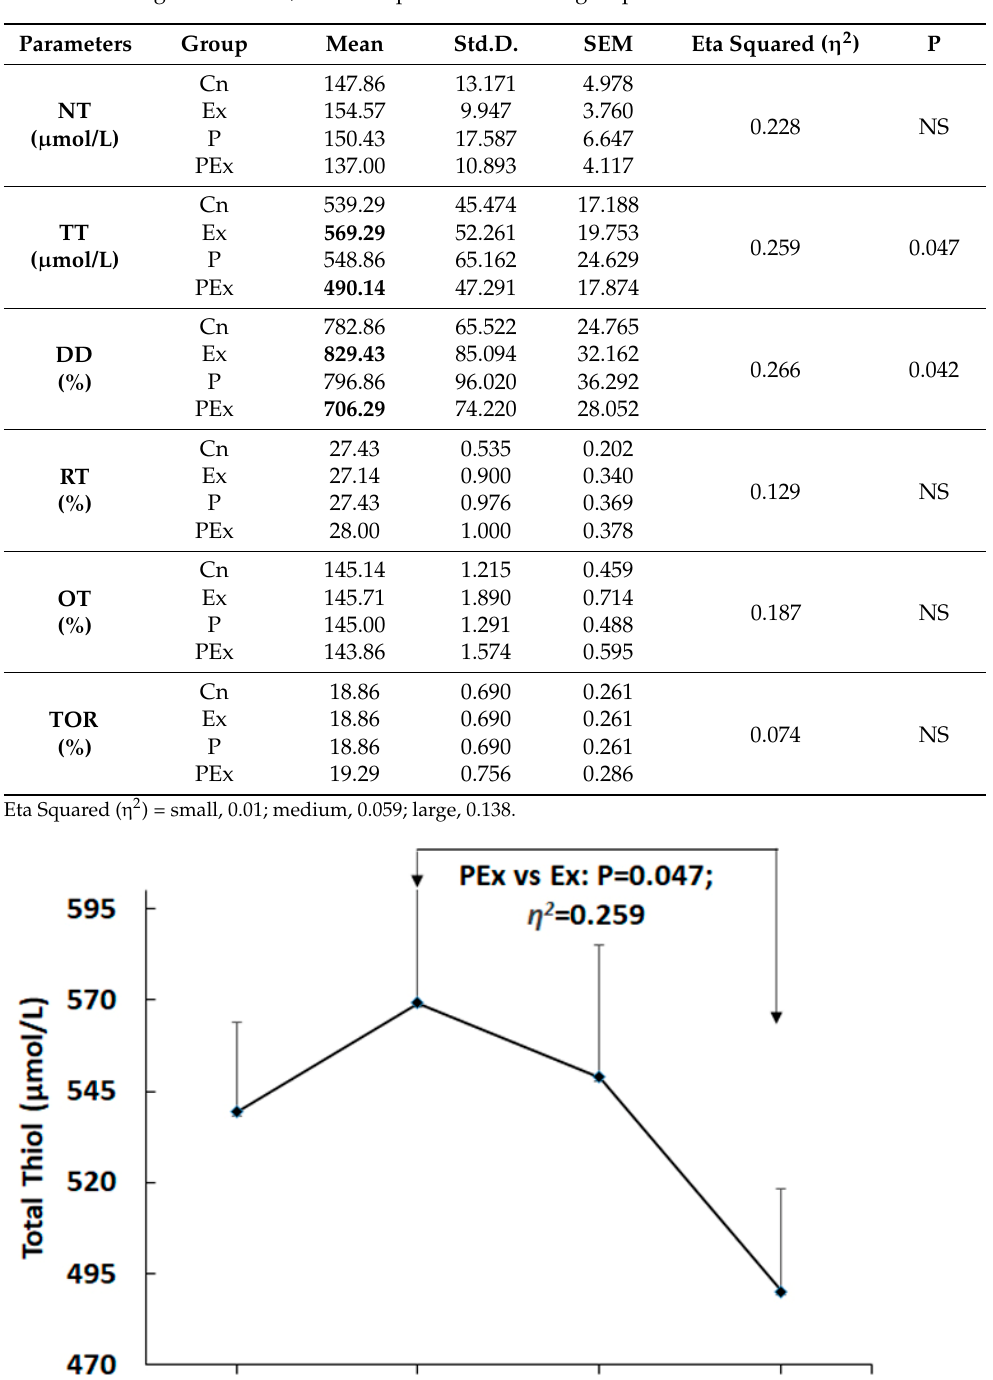
Table 1. Findings of the thiol/disulfide parameters of the groups.